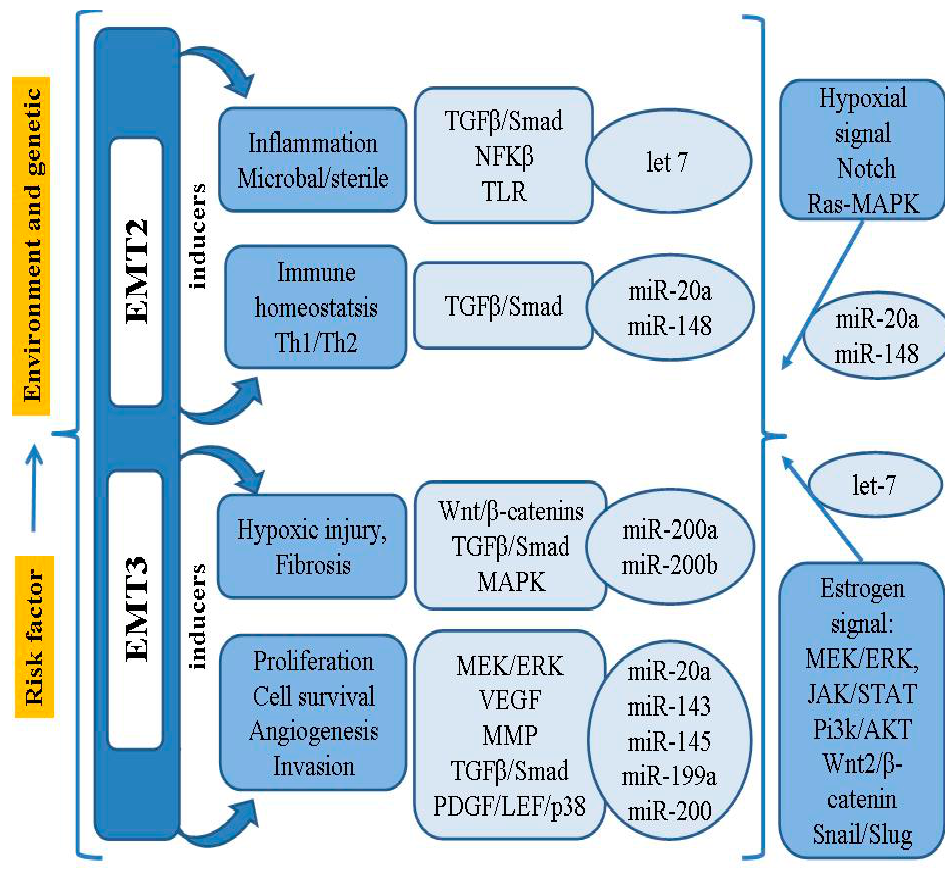
Figure 1. Summary model for the pathogenesis and risk factor of EMT-related